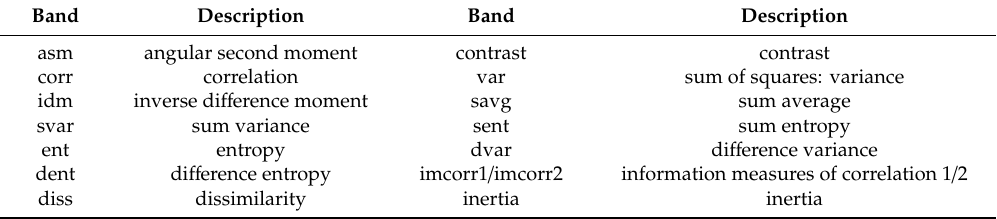
Table 3. GLCM texture measures.